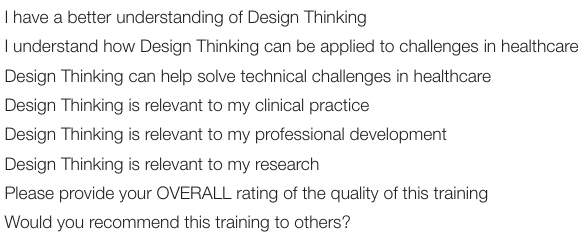
TABLE 1 | Workshop post training survey